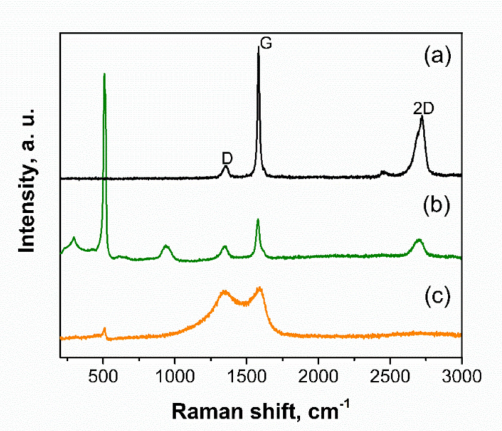
Figure 2. Raman spectra of ( a ) graphite, ( b ) s-BMW, and ( c )